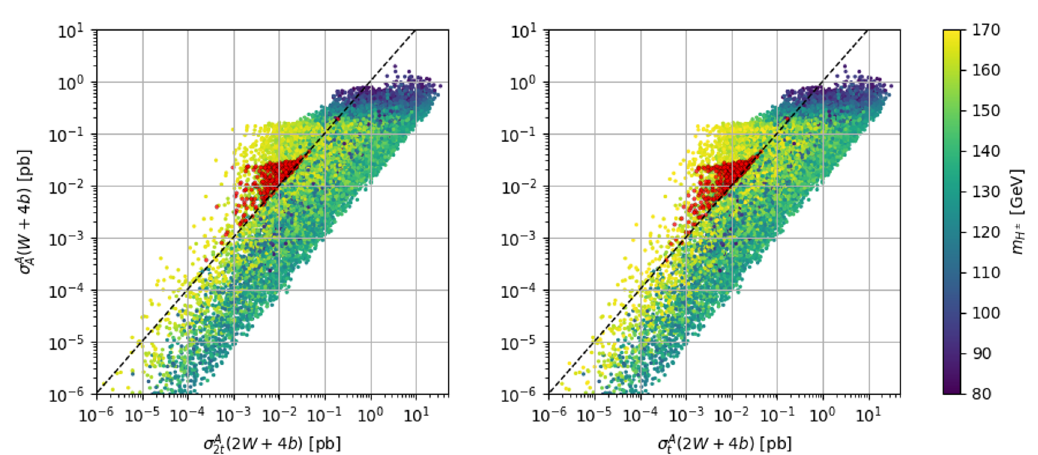
¯ Figure 3 . Values of σ ( pp → H ± A ) × BR( H ± → W ± A ) × BR( A → b b ) 2 are compared with ¯ ¯ those of 2 σ × BR( t → bH + ) × BR( ¯ t → bW − ) × BR( H ± → W ± A ) × BR( A → b b ) (left) and t ¯ t ¯ ¯ σ ( pp → t bH − ) × BR( t → bW + ) × BR( H ± → W ± A ) × BR( A → b b ) (right). The red points identify the values of σ ( H + H − ) × BR( H ± → W ± A ) 2 × BR( A → b ¯ b ) 2 which also exceeds those of the latter two top mediated processes, respectively. The colour bar denotes the mass of the charged Higgs boson. Results are for the 2HDM